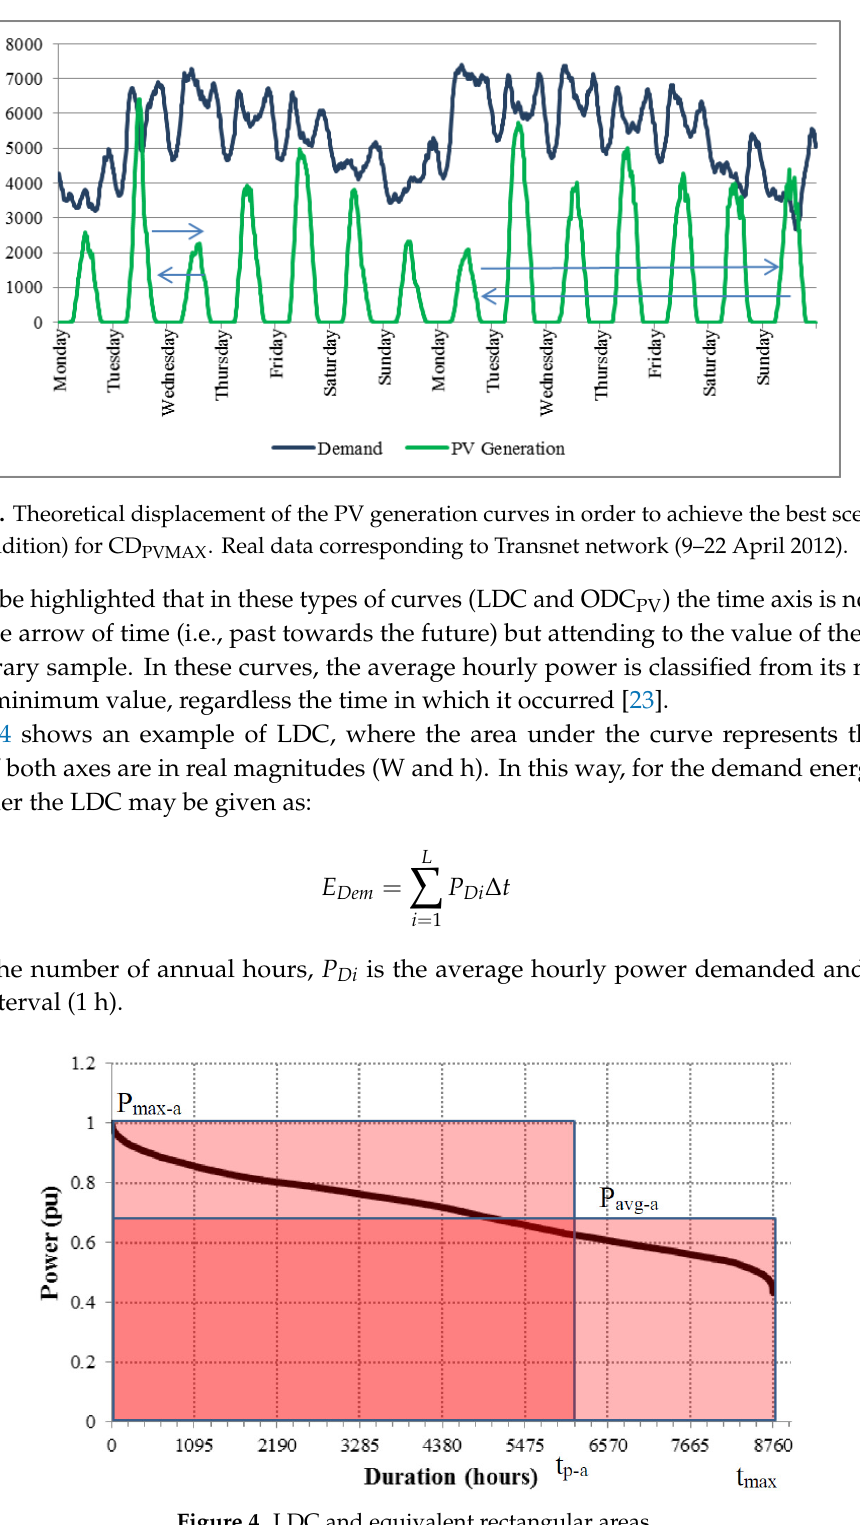
Figure 4. LDC and equivalent rectangular areas.